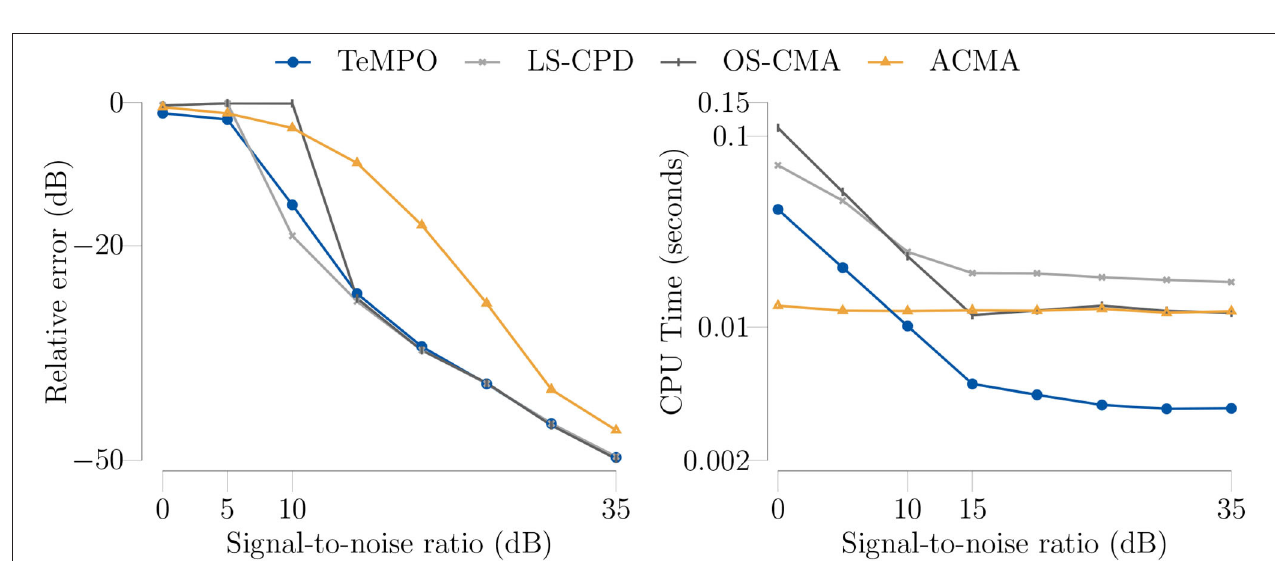
FIGURE 8 | (Left) The median relative errors (dB) of LS-CPD, OS-ACMA, ACMA, and TeMPO with respect to SNR (dB) for an autoregressive model of degree L = 10 with uniformly distributed coefficients between zero and one, sample length K = 600 for 50 trials. TeMPO obtains similar accuracy to LS-CPD, OS-CMA, while obtaining more accurate results than ACMA. (Right) The median CPU times (seconds) with the same settings. TeMPO is faster than other algorithms for SNR > 10 (dB).